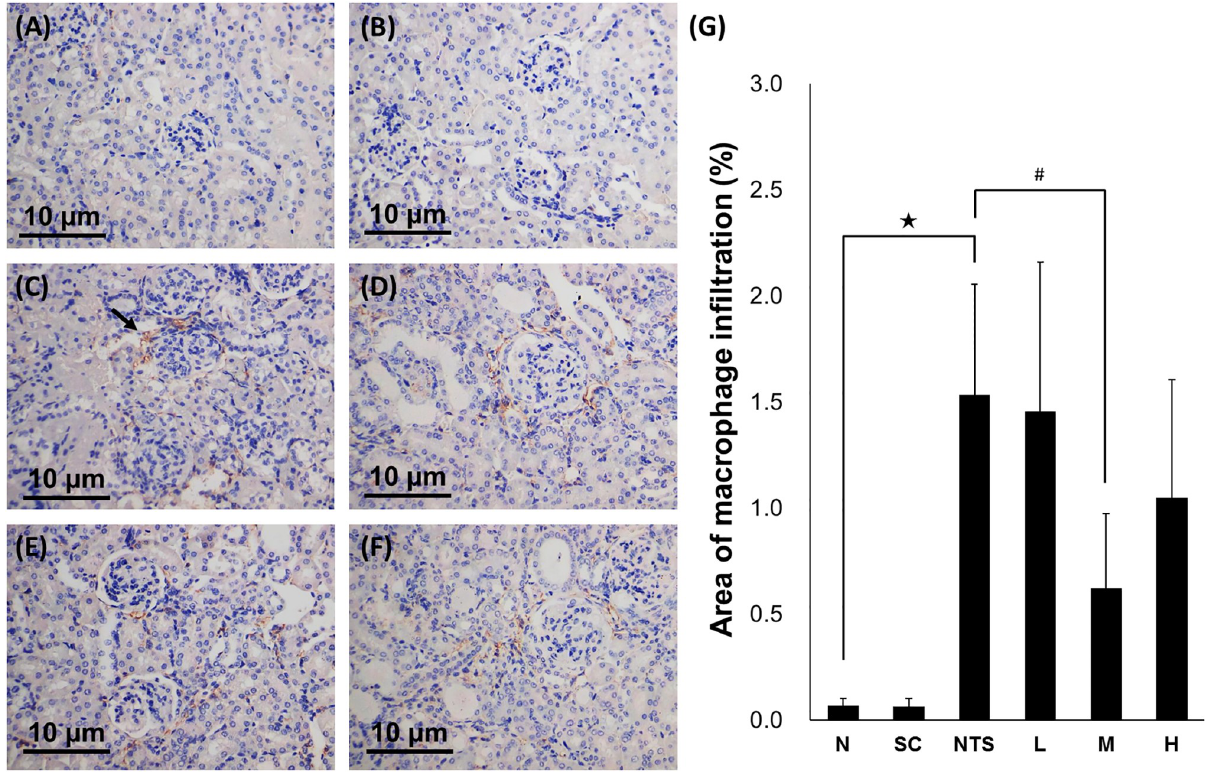
Fig 6. Immunohistochemistry stained renal tissues for F4/80 from different experimental groups ( × 200 magnification). (A) Normal, (B) SSC control, (C) NTS control (arrow, the part of macrophage infiltration), (D) NTS + SSC 5 mg/kg, (E) NTS + SSC 10 mg/kg, and (F) NTS + SSC 20 mg/kg. (G) Quantification of the area of fibrosis for each experimental group. $ p < 0.05 compared to normal group, # p < 0.05 compared to NTS control group.